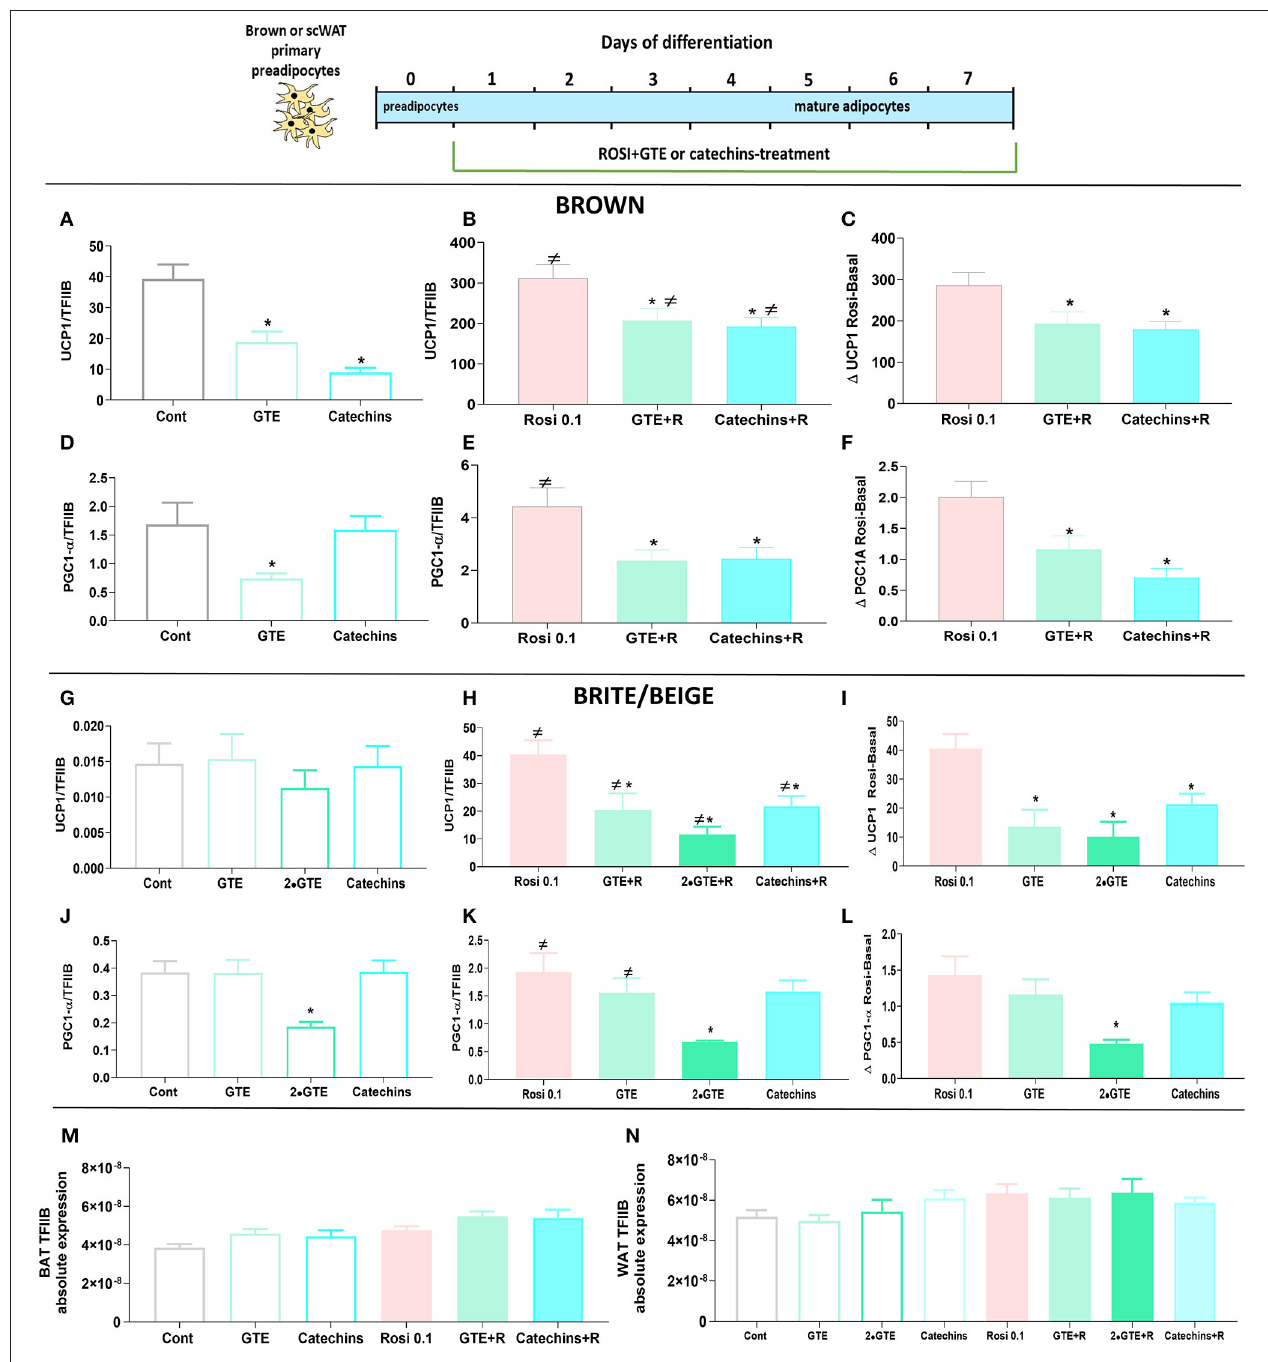
FIGURE 6 | Effect of green tea compounds on rosiglitazone-induced differentiation. Brown and white primary adipocytes were treated with the green tea compounds specified in Figure 1 in the presence or absence of rosiglitazone (Rosi 0.1 µ M). Brown adipocyte Ucp1 mRNA levels in basal (A) and rosiglitazone-stimulated states (B) and the rosiglitazone-induced change (C) . (D–F) : results for Pgc1 α . (G–I) results for white adipocyte Ucp1; (J–L) results for white adipocyte Pgc1 α . Ucp1 and Pgc1 α mRNA levels were normalized to the TFIIB levels in each sample ( M TFIIB levels in brown and N in white adipocytes). The results are means ± SEM of five independent experiments, each performed in duplicate. Statistics are as in Figure 1 .